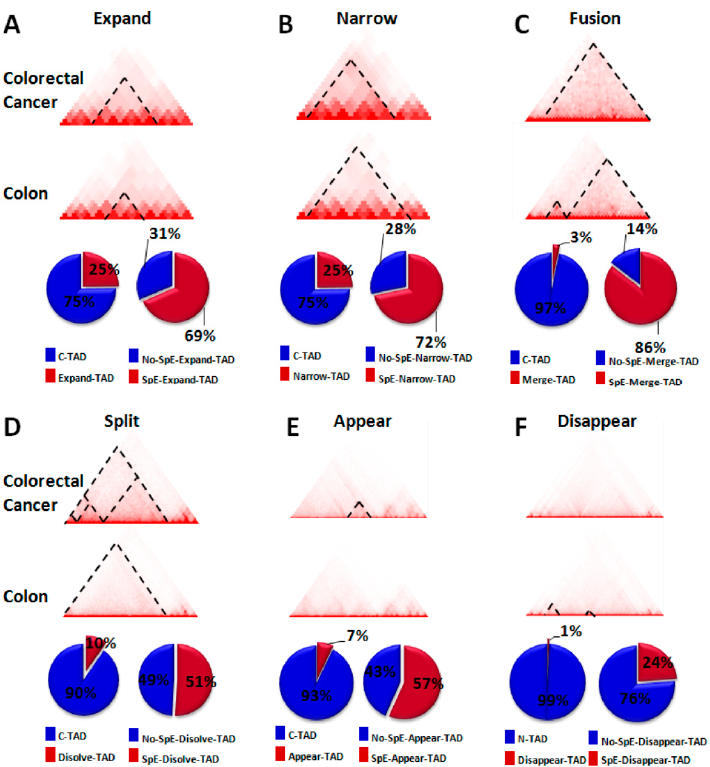
Figure 4. Changes of TAD boundaries in colorectal cancer cells compared to normal colon cells. ( A ) Expanded TADs in colorectal cancer cells compared to normal colon cells. ( B ) Narrowed TADs in colorectal cancer cells compared to normal colon cells. ( C ) Fusion TADs in colorectal cancer cells, where two or more TADs in normal colon cells are fused to one TAD in colorectal cancer cells. ( D ) Split TADs in colorectal cancer cells, where new insulation boundaries are formed in one TAD in colorectal cancer cells. ( E ) Appeared TADs in colorectal cancer cells that do not exist in normal colon cells. ( F ) Disappeared TADs, which are TADs in normal colon cells that disappear in colorectal cancer cells. The pie charts ( A – F ) show the percentages of specific categories of boundary-changed TADs (category-TAD) in the total changed TADs (C-TAD) in colorectal cancer cells (the first pie chart in each panel) and the percentages of specific categories of boundary- changed TADs containing colorectal-specific enhancers (SpE-category-TAD) in the total changed TADs of this category (the second pie chart in each panel).